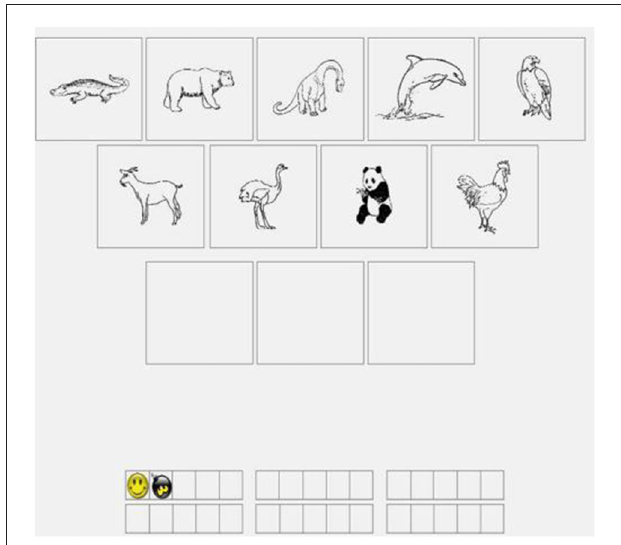
FIGURE 3 | Demonstration of locations running WM